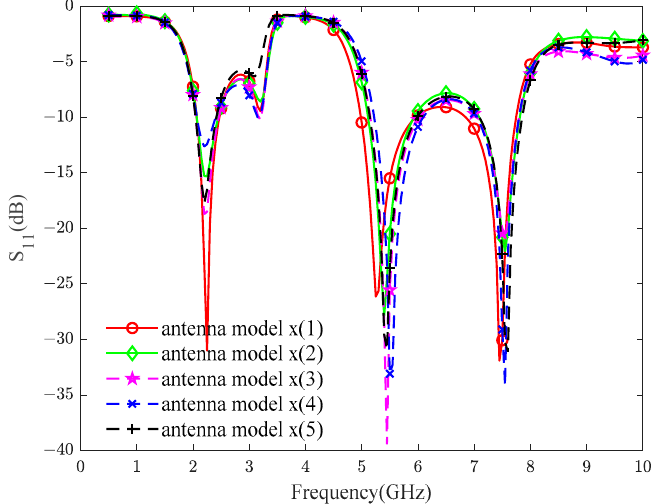
Figure 12. Simulated results of the reflection coefficient of antenna models.